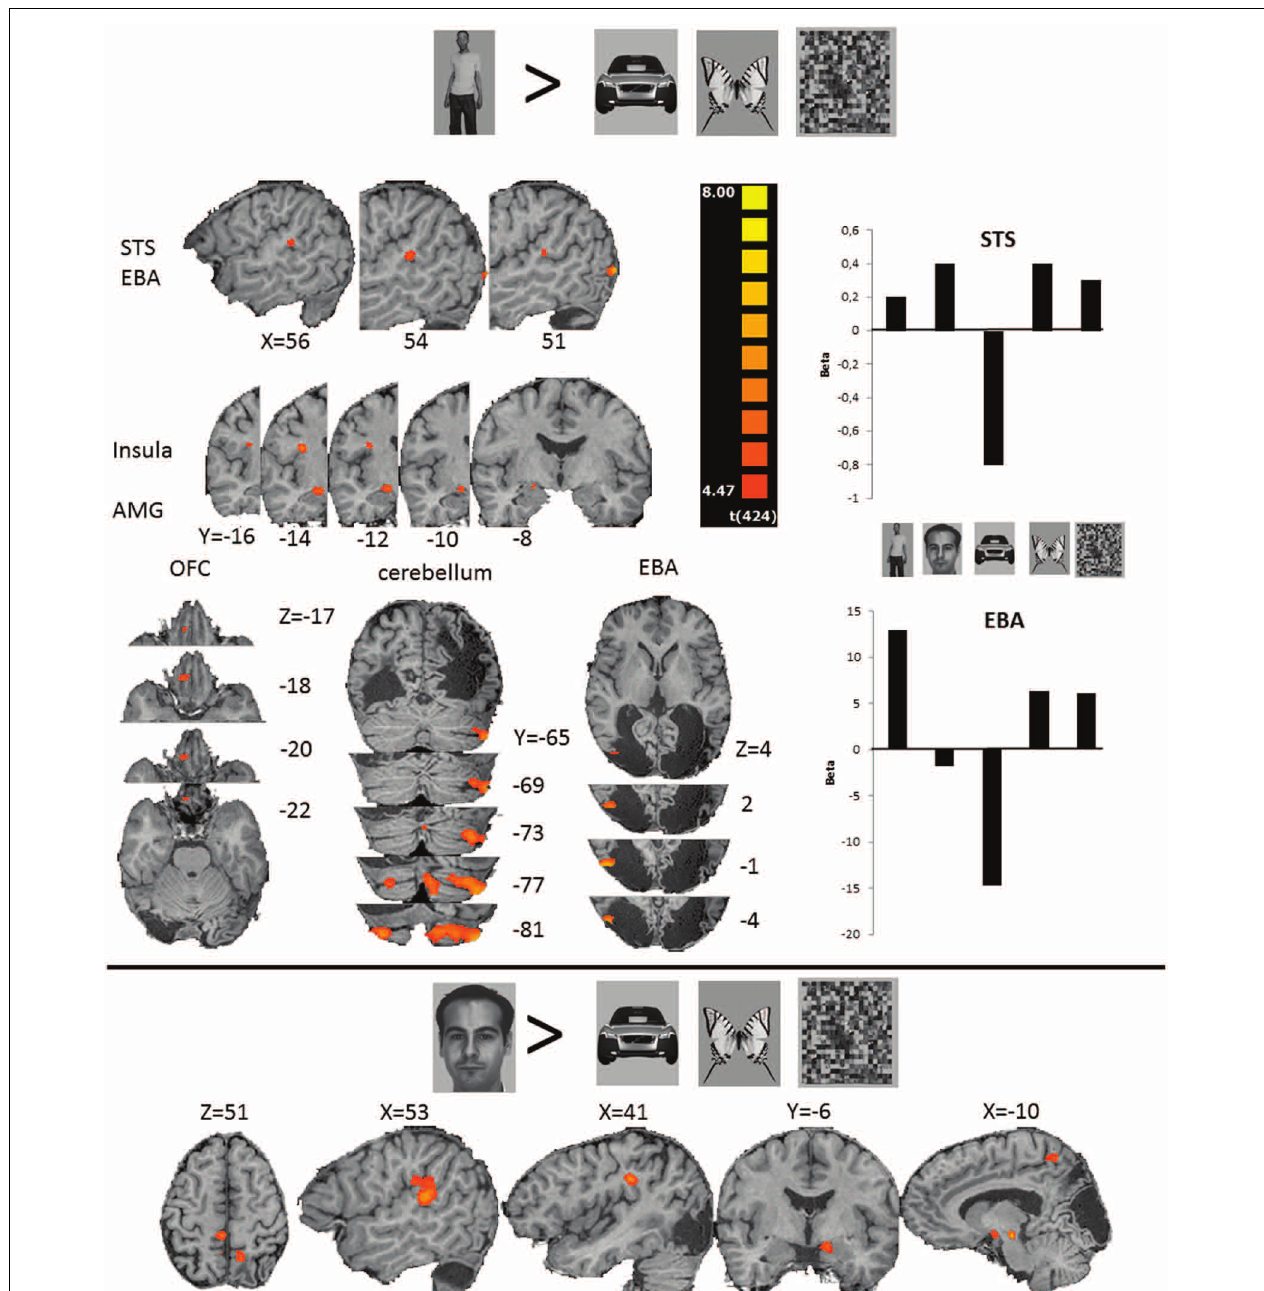
FIGURE 3 | fMRI results. The top panel shows the activation clusters resulting from bodies vs. butterflies, cars, and scrambles (stimulus examples are shown on top). STS, superior temporal sulcus; EBA, extrastriate body area; AMG, amygdala; OFC, orbito-frontal cortex; superior temporal sulcus; EBA; insula and amygdala; cerebellum. Parameter estimates (Beta-values) for